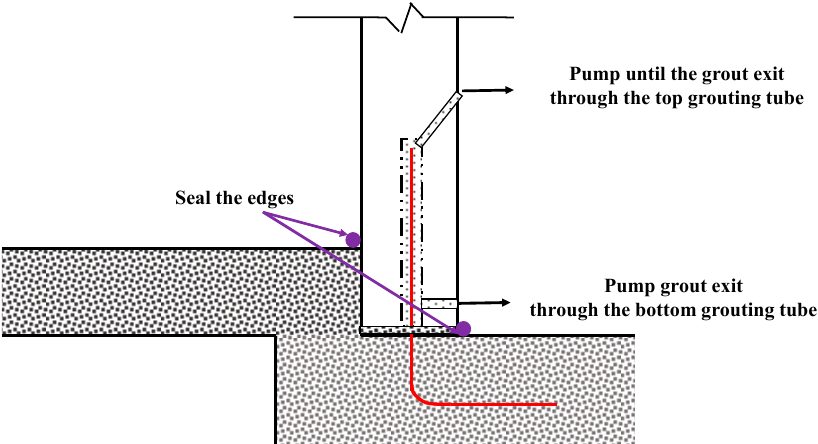
Figure 11. Propping method of masonry walls.